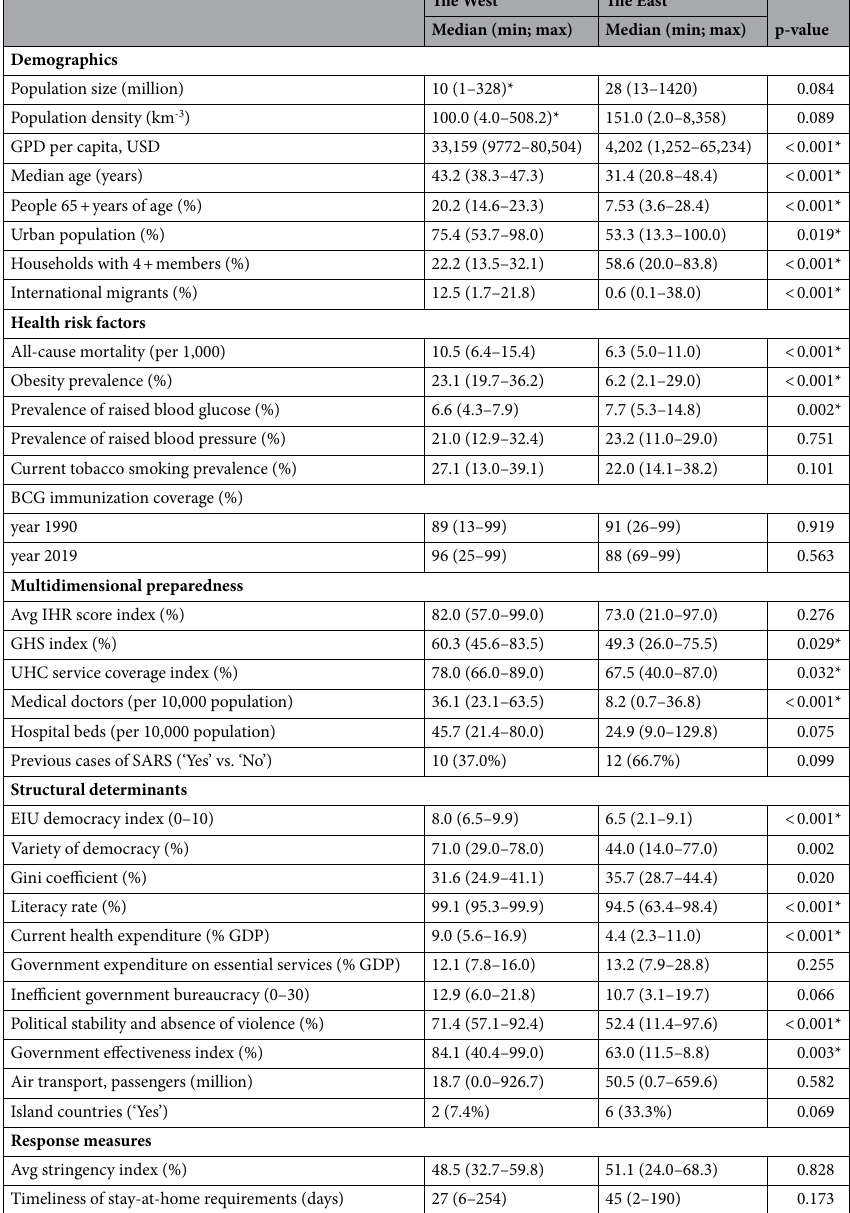
Table 3. Demographics, health risk factors, preparedness and response indicators, structural economical- political determinants within the two regions of interest. P-values reported were computed with Mann– Whitney U test or Pearson’s chi-squared test between the West and the East. BCG Bacillus Calmette-Guerin; COVID-19 coronavirus disease 2019; EIU Economist intelligence unit; GDP gross domestic product;